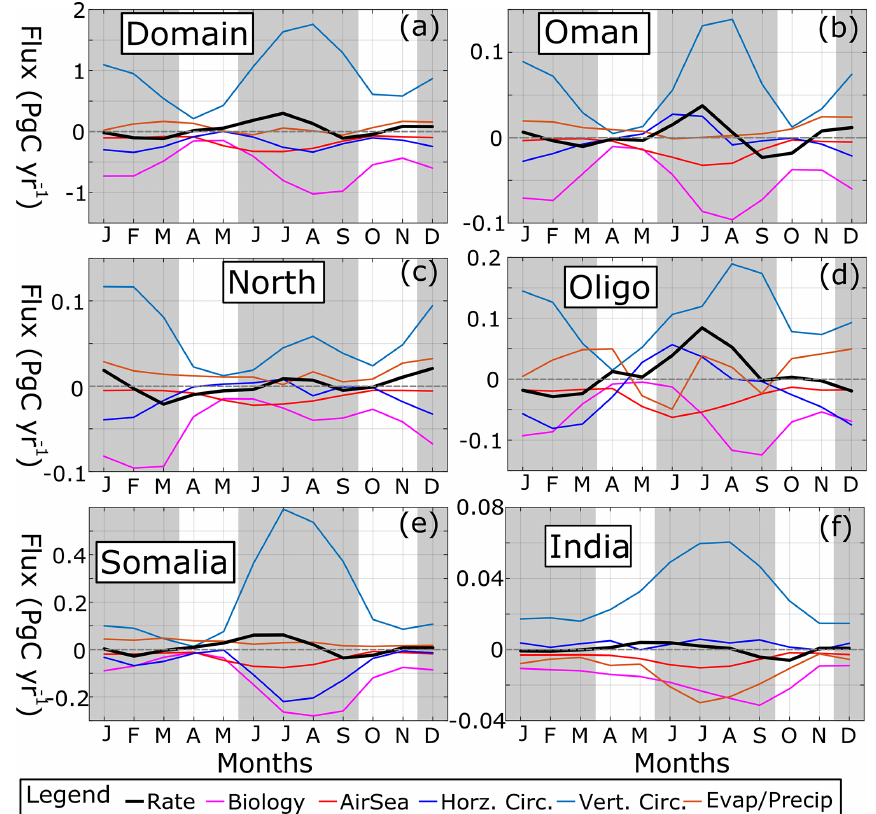
Figure 12. Time series of DIC fluxes (PgCyr − 1 ) in the top 20m for (a) the domain, (b) Oman, (c) north AS, (d) oligotrophic central AS, (e) Somalia, and (f) India. Dashed gray line shows x = 0 axis. Gray shading denotes summer and winter